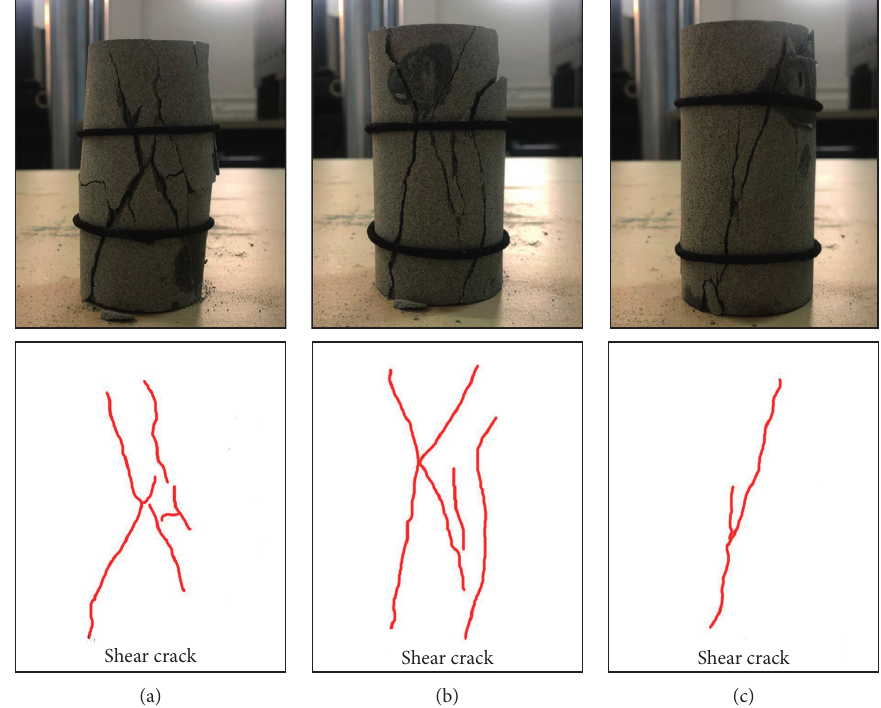
Figure 6: Sketch of sandstone failure characteristics and main crack distribution under uniaxial compression. (a) UC-1. (b) UC-2. (c)